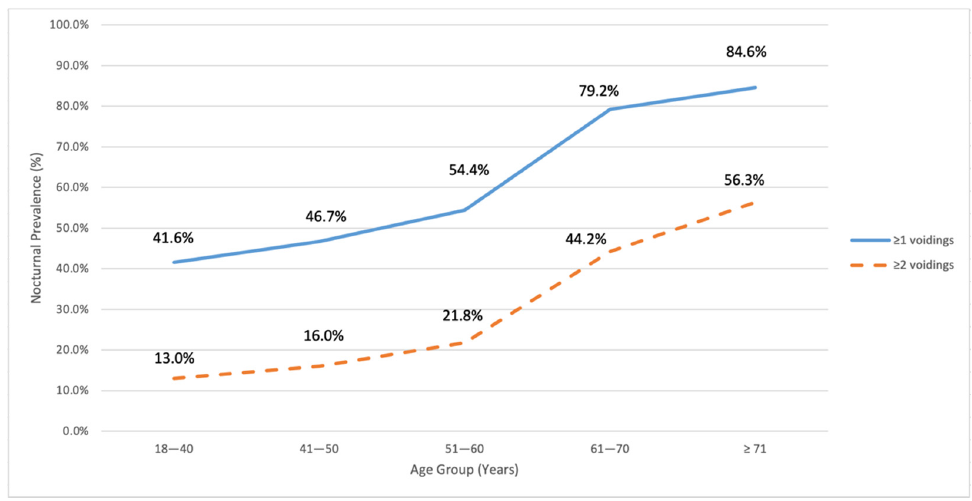
Figure 1. Prevalence of nocturia in different age groups.